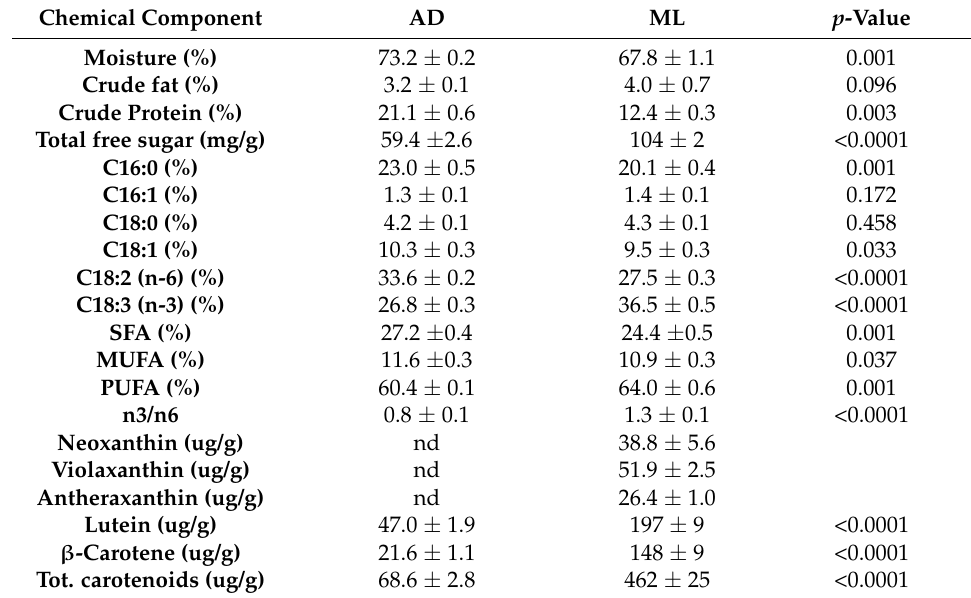
Table 1. Compositional analysis of the artificial diet (AD) and mulberry leaves of Florio cultivar (ML). Chemical